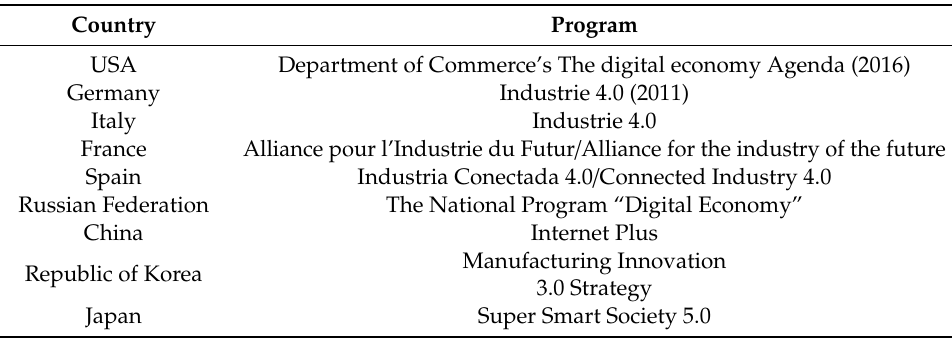
Table 1. National programs for the development of the digital economy